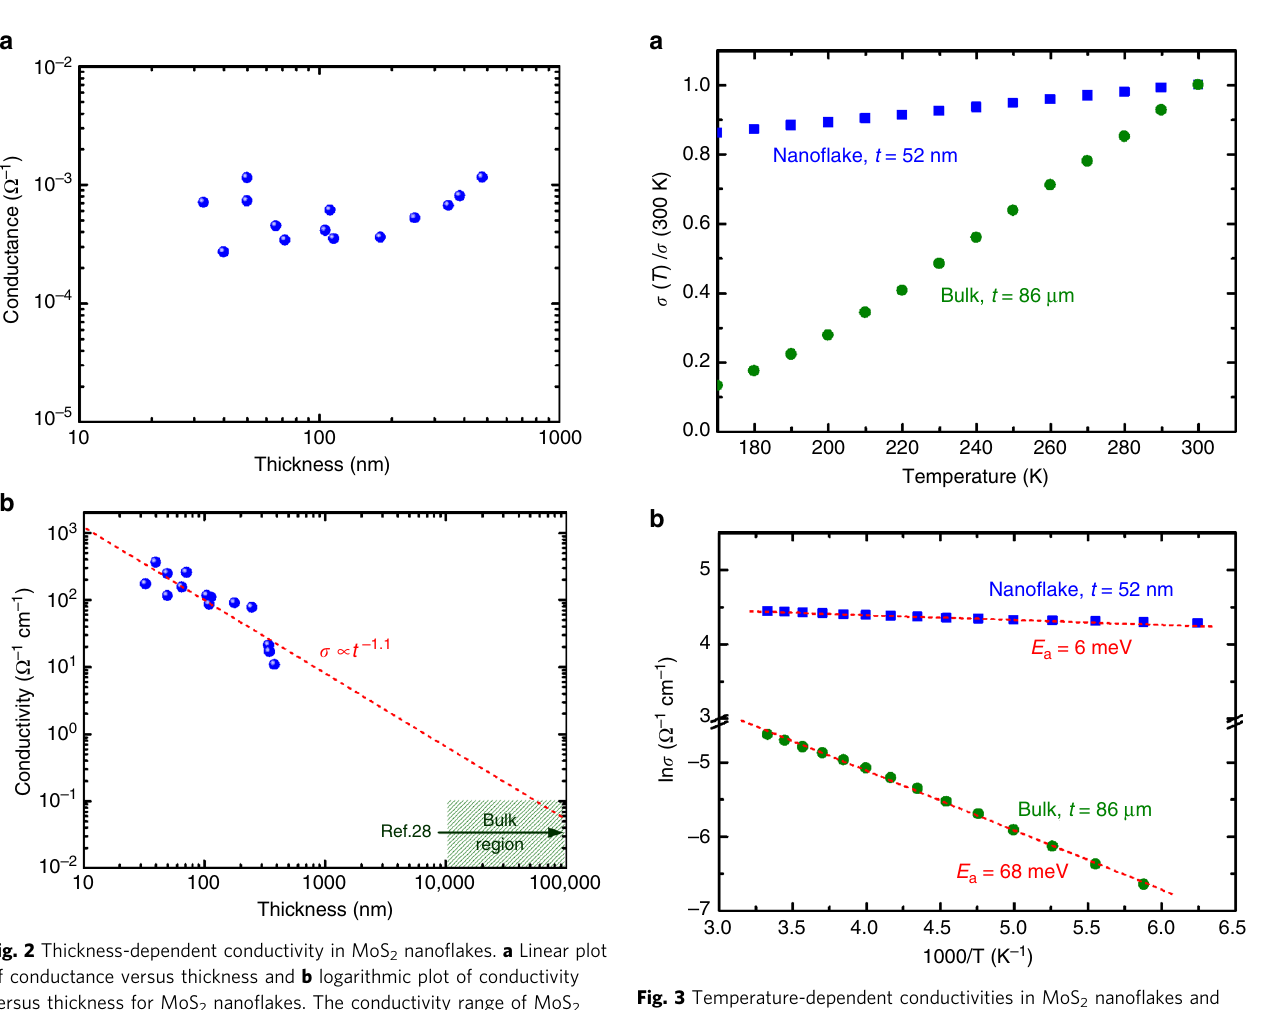
where ρ 2D is the resistivity of the 2D conductor (or sheet resistance 51 ). According to Eq. (3), the R value is proportional to l / w . Figure 4b depicts the plot of R versus l / w curve for MoS 2 fl akes. The overall R values followed a linear relationship with l / w . The R c at 440 Ω and ρ 2D at 450 Ω could also be obtained by fi tting the intercept and slope of the R versus l / w curve, respectively. The TLM analysis clearly indicates that MoS 2 nanostructures follow a 2D transport behavior rather than a 3D mode. The result supports the aforementioned hypothesis of surface-dominant conduction in MoS 2 . Although MoS 2 nano fl akes are thicker than monolayers, the quasi-2D transport in fl akes may allow a fair comparison of the speci fi c contact resistance ( R sc = R c × w ) among these 2D systems 52 . The typical w values of our fl ake devices are 1 – 3 μ m.